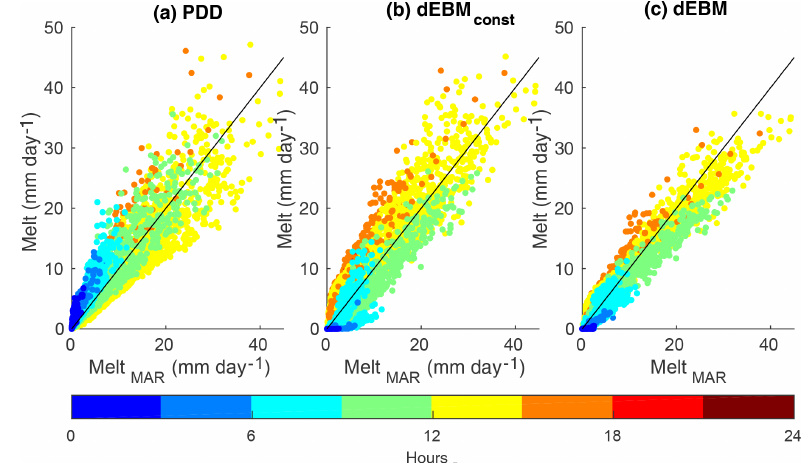
Figure 2. Multi-year monthly mean melt rates averaged over the years 1948–2016 and predicted by (a) the PDD scheme, (b) the dEBM const and (c) the dEBM against respective MAR melt rates. Colours reflect the length of the daily melt period. Identity is displayed as a black line in all panels for comparison.